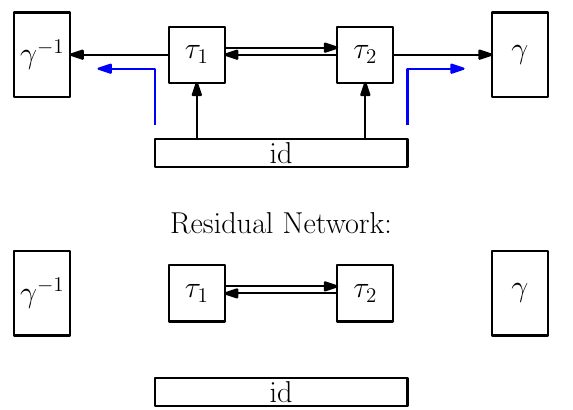
Figure 22 . The flow network corresponding to the two-tensor network. The flow is shown in blue. All the weights are taken to be 1 here.